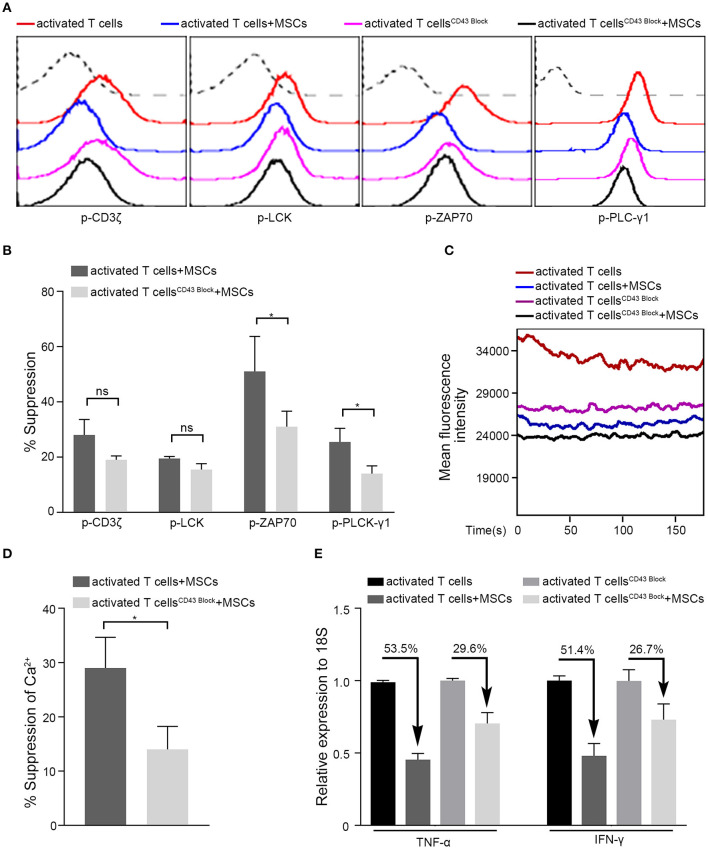
MSCs exert rapid immunosuppressive actions on T cells through CD43. Four groups were analyzed: activated T cells with and without MSCs coculture, CD43-blocked activated T cells with and without MSCs coculture. (A) The phosphorylation levels of CD3ζ, LCK, ZAP70, and PLC-γ1 in activated T cells of the four groups above, the dotted curve represents isotype. (B) Bar graphs show the suppression percentages of p-CD3ζ, p-LCK, p-ZAP70, and p-PLC-γ1. Comparison is between activated T cells cocultured with MSCs and CD43-blocked activated T cells cocultured with MSCs. (C) Cytosolic Ca2+ levels in activated T cells of the four groups were tested by flow cytometry. (D) The suppression percentages of the two MSCs-cocultured groups described in (B) are shown. (E) Quantitative reverse transcription–polymerase chain reaction (qRT-PCR) analysis of TNF-α and IFN-γ mRNA expressions in activated T cells from the four groups. The percentages of decrease after cocultured with MSCs are shown. All experiments were repeated three times. Data are presented as the mean ± SEM for each group. Significant differences are indicated as follows: ns, no statistical significance; *p < 0.05.